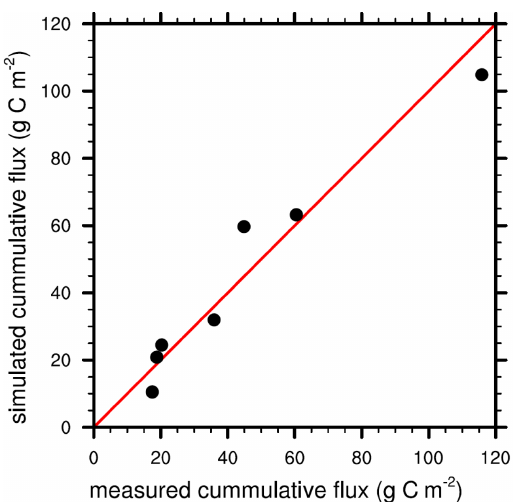
Fig. 3. Measured versus simulated cumulative methane emissions for each site. Emissions for each site are integrated over the time spanned by the measurements. The errors of the measurements (mostly per hour) are up to